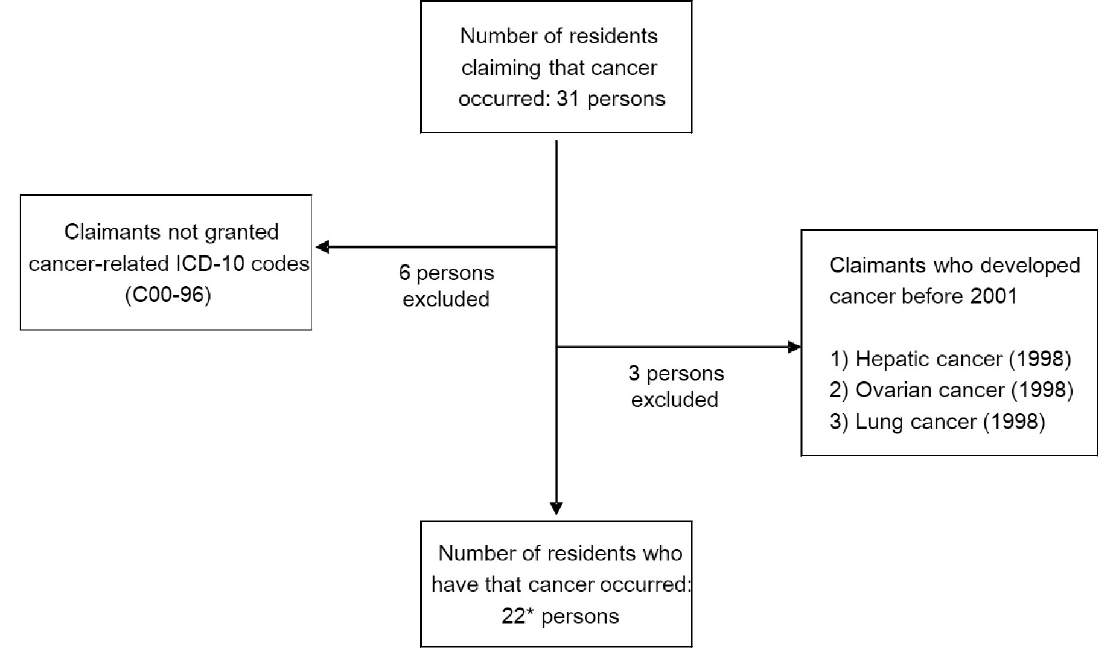
Fig 3. Validation of cancer cases in the Jang-jeom village in 2001–17. � : There was one person with two cancers (colon cancer, gallbladder and biliary cancer), so the total number of cases was 23.